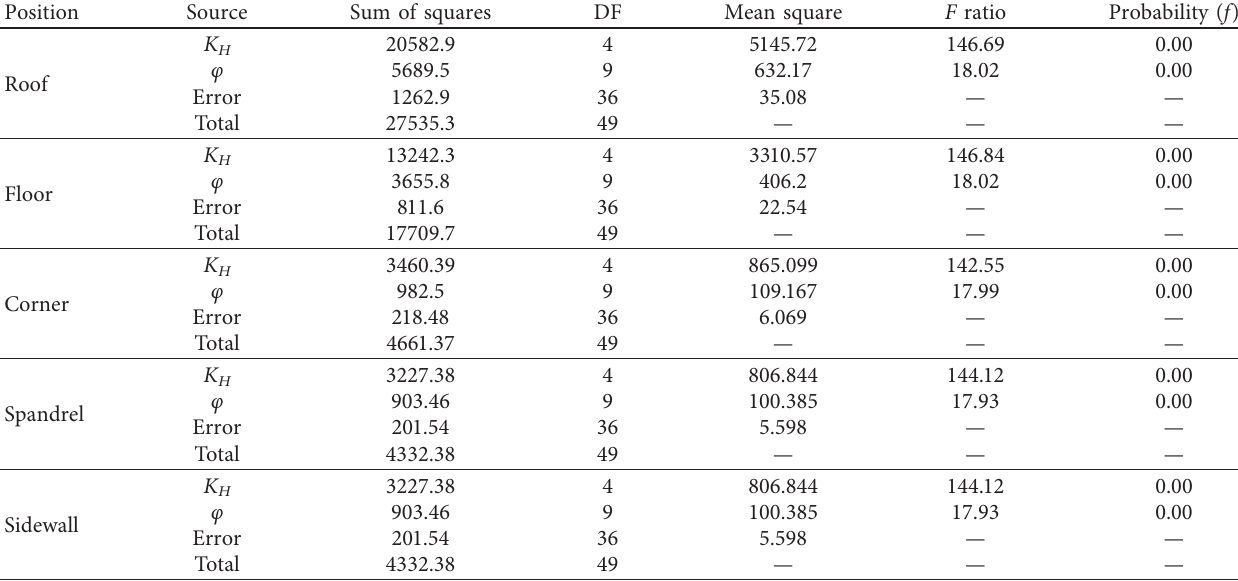
of the different positions in various in situ stress states. θ